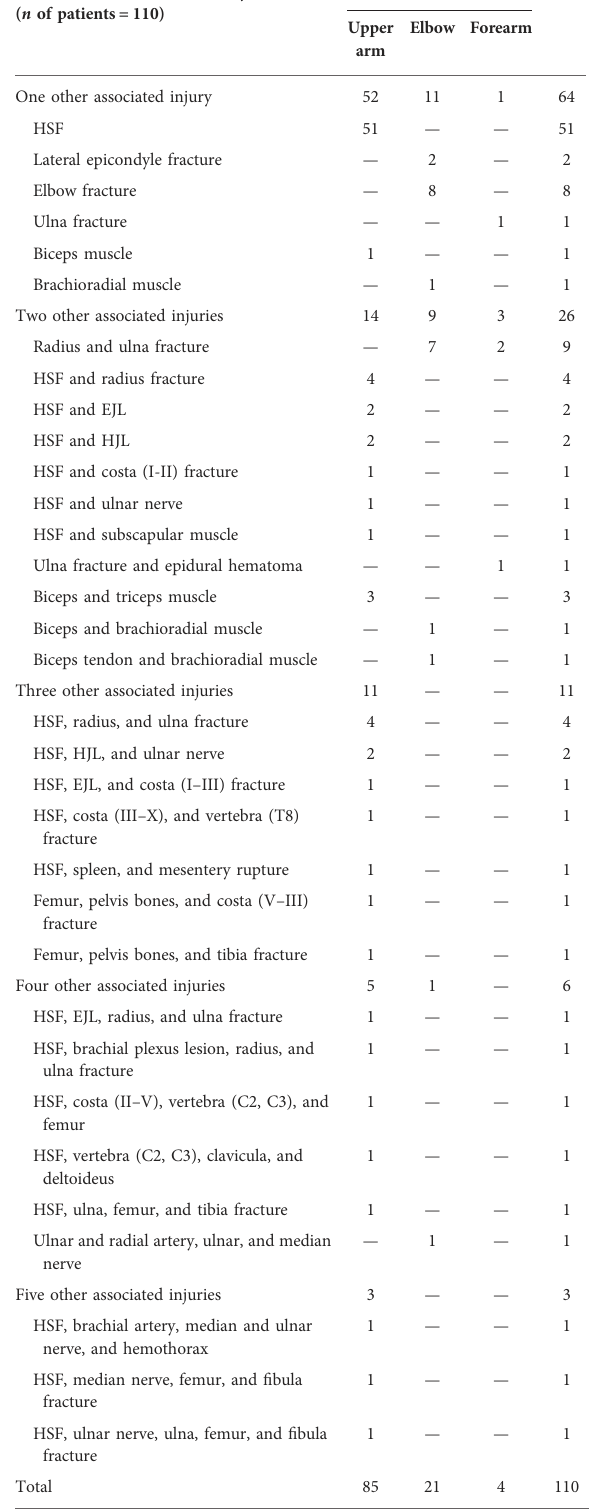
TABLE 3 Cause of trauma, age, and gender distribution in 129 traumatized patients. Cause of trauma ( n of patients = 129)